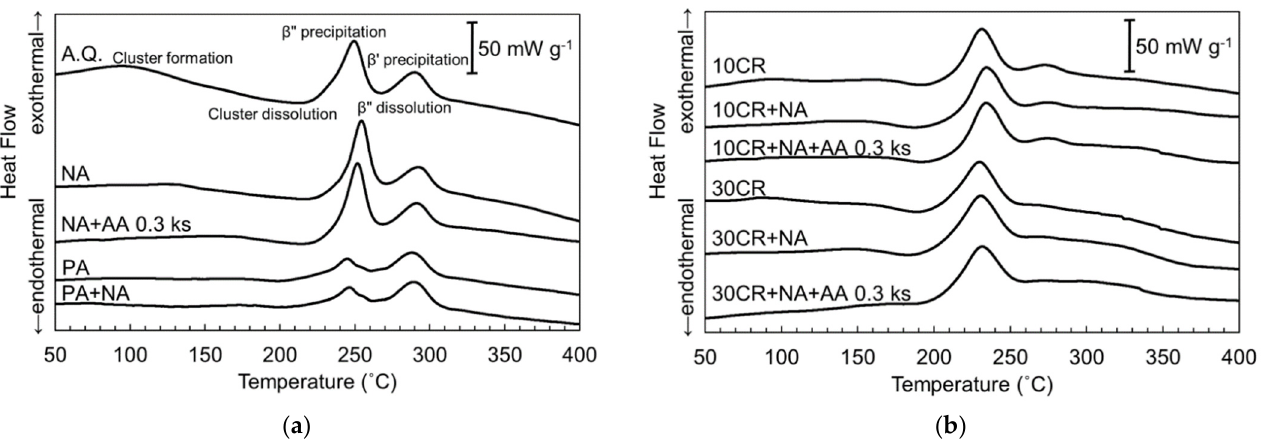
Figure 5. DSC curves of ( a ) A.Q., NA, PA and PA+NA samples and ( b ) 10CR, 10CR + NA, 30CR and 30CR + NA samples.